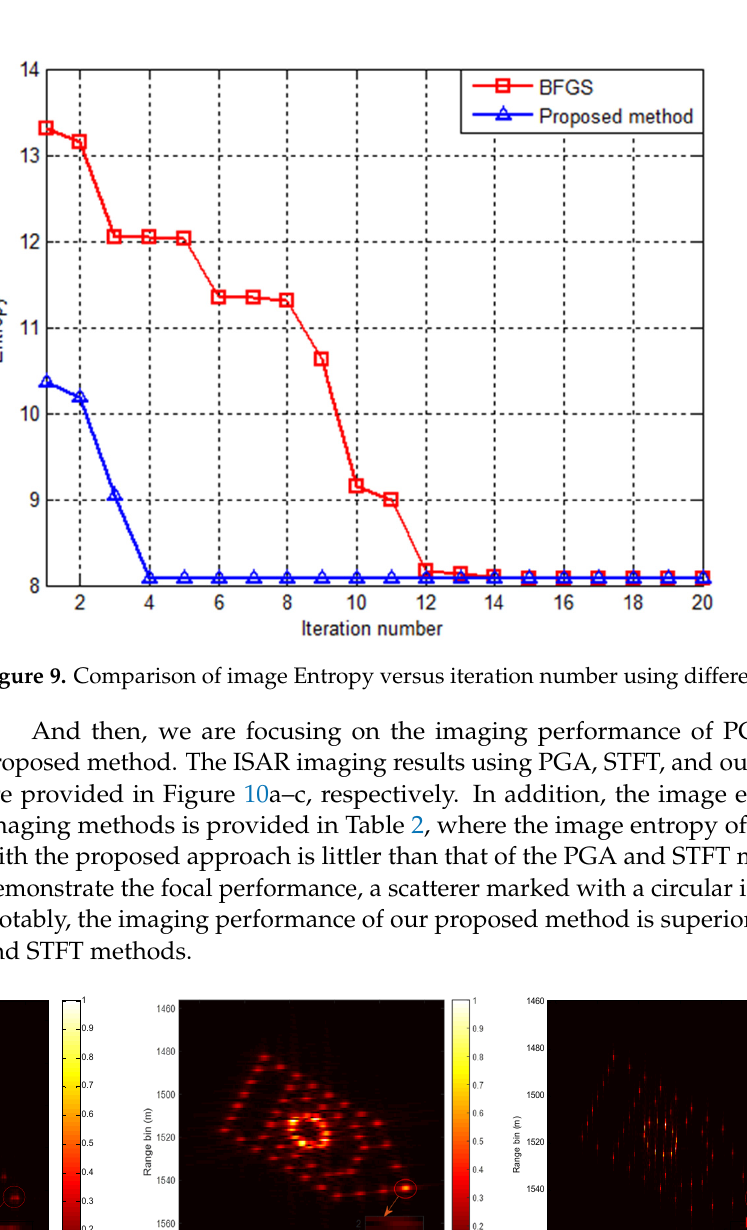
Figure 8. Coarse estimation results with the GRFT method.